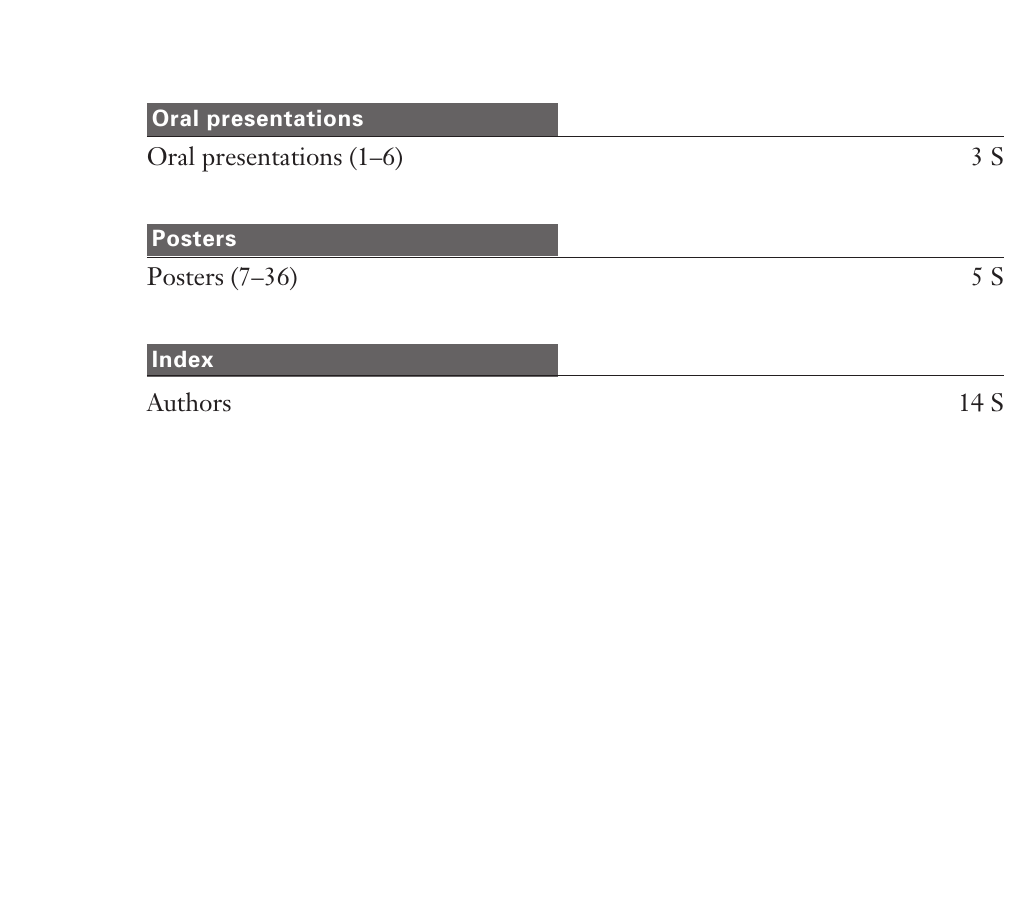
Table of contents SWISS MED WKLY 2008;138(Suppl 162) ·